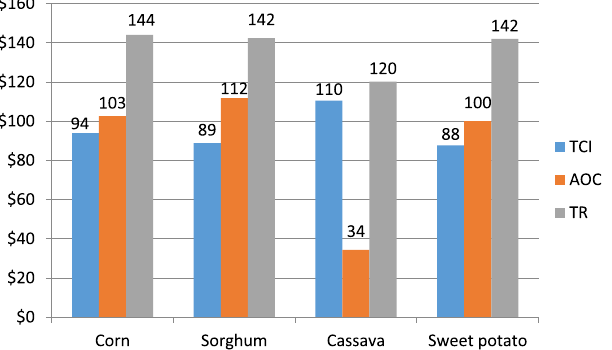
Figure 1. TCI, AOC, and TR of bioethanol produced from selected starchy feedstocks. TCI total capital investment, AOC annual operating cost, TR total revenue.